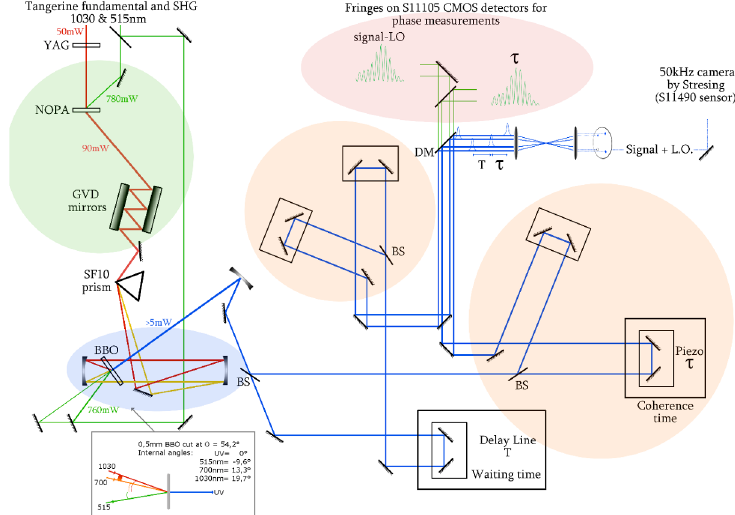
range at a repetition rate of up to 200 kHz. ASFG is achieved by engineering the required angular dispersion of the red-NIR pulse in order to fulfil the phase matching condition for SFG in BBO of all its spectral components with the 515-nm, nearly monochromatic (300-fs long, Fourier Limited - FL) second harmonic of the fundamental pulse. More precisely this angular dispersion is computed to be 3.38*10 -4 rad/nm, to ensure relative internal angles with the crystal axis ranging from 67.5° to 73.9° for wavelengths spanning from 700 to 1030 nm, respectively. The red-NIR pulse is thus dispersed at the apex of a 60° SF10 prism, magnified by a 1/8 telescope and overlapped with the 515-nm pulse coming at an internal angle of 44.6° with respect to the crystal axis. The resulting UV pulse is shown in fig. 1, supporting 10-fs FL pulse duration. Accurate optimization of the angular dispersion of the incoming Red-NIR pulse is critical to optimize both the spectral width and the spatial profile of the UV pulse. Two pulse pairs are produced in two interferometers and overlapped again in the BOXCARS geometry (see Fig. 2), where the UV pulse duration is characterized by a transient grating - FROG measurement. The reconstructed pulse duration is observed to be 15-fs (see Fig. 1).